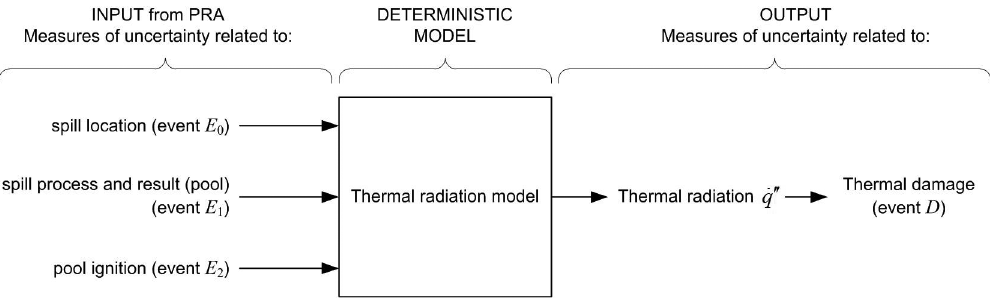
model in the framework of a transportation